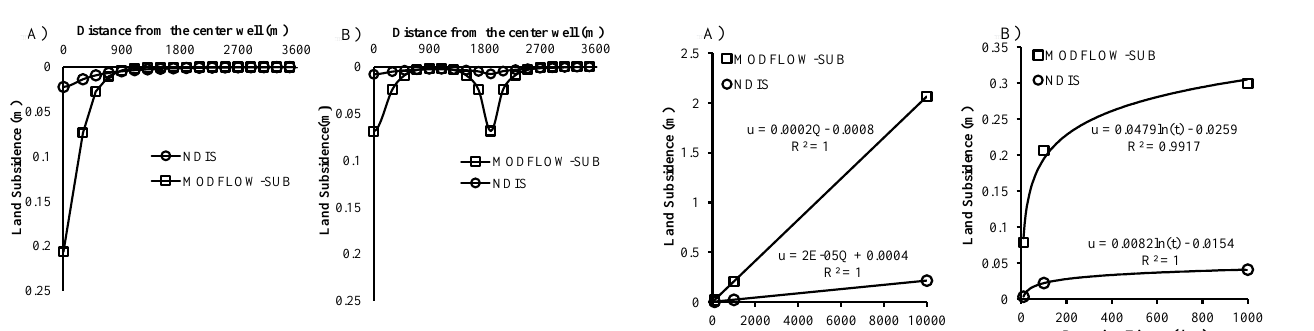
Figure 2. Comparison of land subsidence predicted by the NDIS and MODFLOW-SUB after 100 days pumping; (a) Land subsi- dence for a single well, (b) Land subsidence for three wells after 100 days pumping.